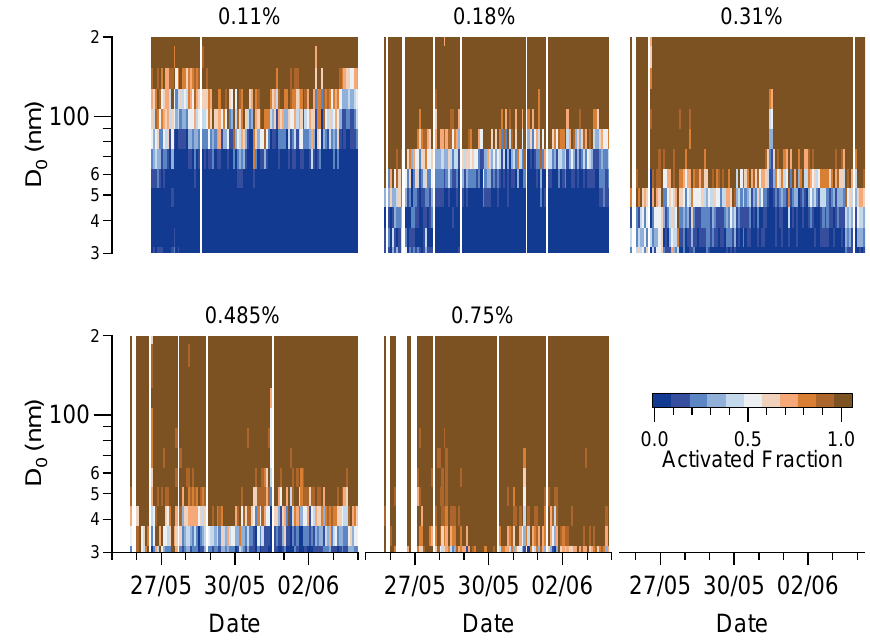
Fig. 6. Time series of the fraction of CN activation into CCN as a function of D 0 at the set supersaturations. The 5 panels correspond to the 5 supersaturations set by the CCN counter (0.11%, 0.18%, 0.31%, 0.485% and 0.75%). The left hand axes is the D 0 and the colour scale is the activated